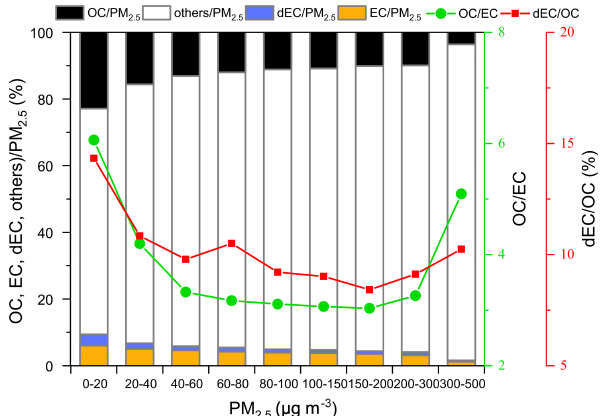
Figure 4. Carbonaceous species fractions of PM 2 . 5 and OC / EC ratios at different PM 2 . 5 concentration intervals at NUIST from June 2015 to August